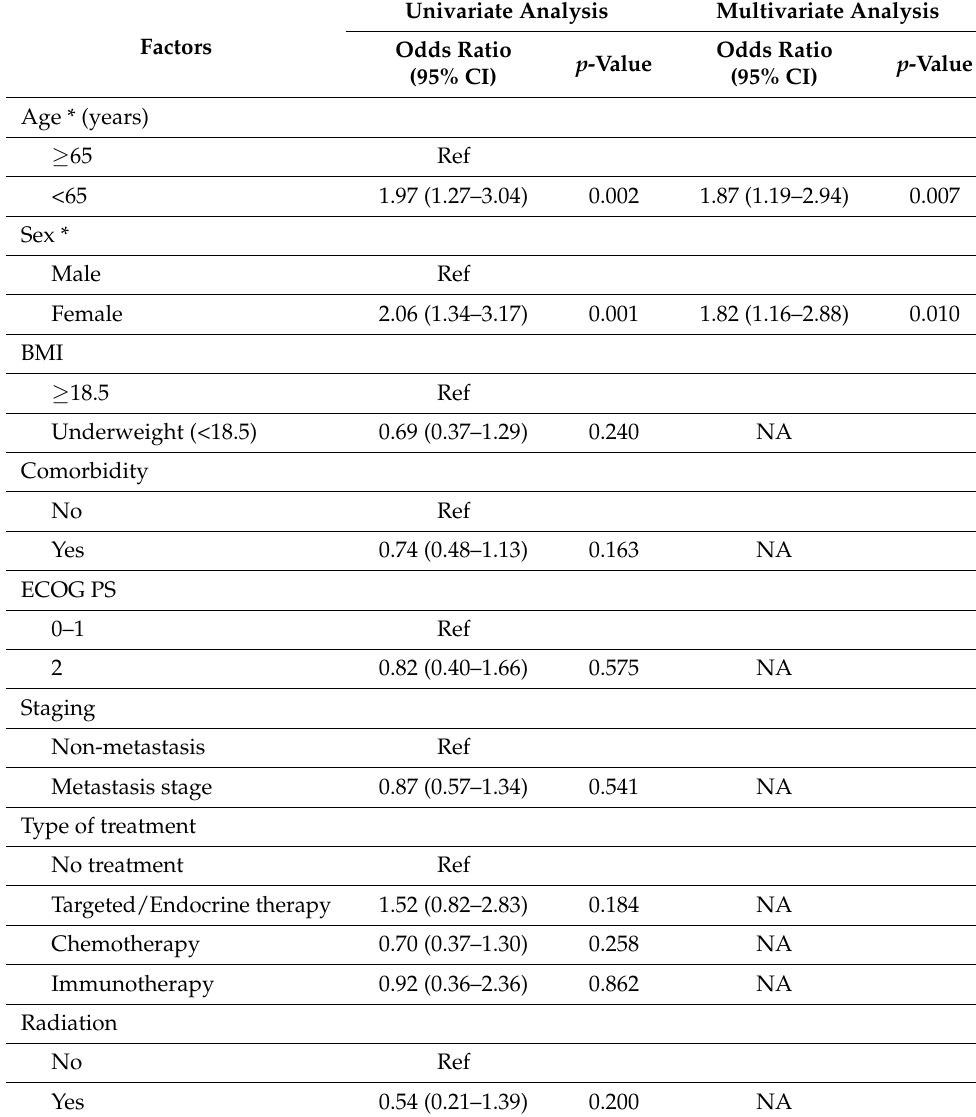
Table 3. Factors associated with any adverse events following the booster dose with the mRNA vaccine.